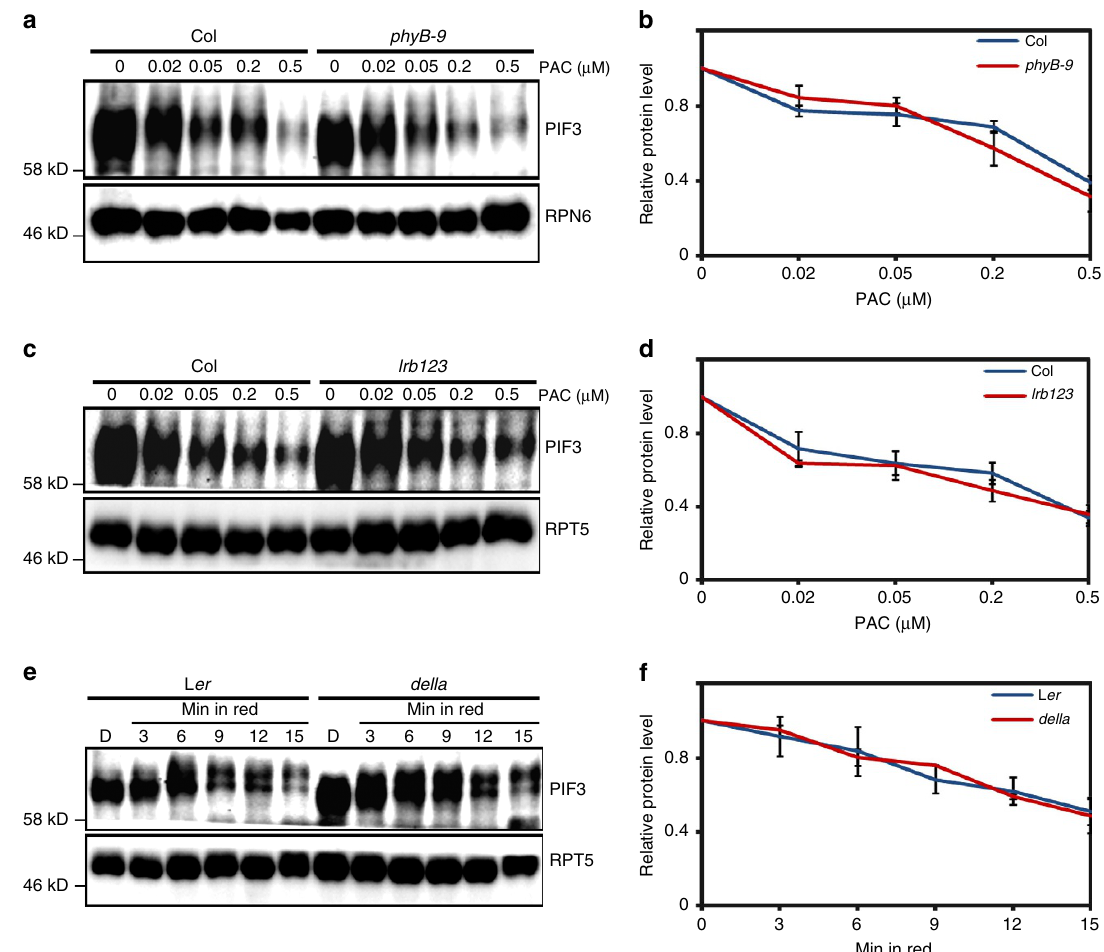
Figure 6 | DELLAs and phyB/LRBs regulate the degradation of PIF3 independently. ( a ) Endogenous PIF3 protein levels in the 4-day-old dark-grown seedlings of phyB-9 mutant and its wild-type counterparts grown on medium containing different concentrations (0, 0.02, 0.05, 0.2 and 0.5 m M) of PAC. RPN6 was used as a loading control. ( b ) The quantification of the western blot results from ( a ) using image J software. PIF3 protein levels were normalized to RPN6 loading control. The value of starting point was set to 1. Quantitative data are shown as means ± s.e.m., n ¼ 3. ( c ) Endogenous PIF3 protein levels in 4-day-old dark-grown lrb1lrb2lrb3 triple-mutant ( lrb123 ) and wild-type seedlings grown on medium containing different concentrations (0, 0.02, 0.05, 0.2 and 0.5 m M) of PAC. RPT5 was used as a loading control. ( d ) The quantification of the western blot results from ( c ) using image J software. PIF3 protein levels were normalized to RPT5 loading control. The value of starting point was set to 1. Quantitative data are shown as means ± s.e.m., n ¼ 3. ( e ) Endogenous PIF3 protein levels in 4-day-old seedlings of della mutant and its wild-type counterparts during dark to red light transition. Dark-grown seedlings were irradiated with red light (5 m molm (cid:2) 2 s (cid:2) 1 ) for the indicated times. RPT5 was used as loading control. ( f ) The quantification of the western blot results from ( e ) using image J software. PIF3 protein levels were normalized to RPT5 loading control. The value of starting point was set to 1. Quantitative data are shown as means ± s.e.m., n ¼